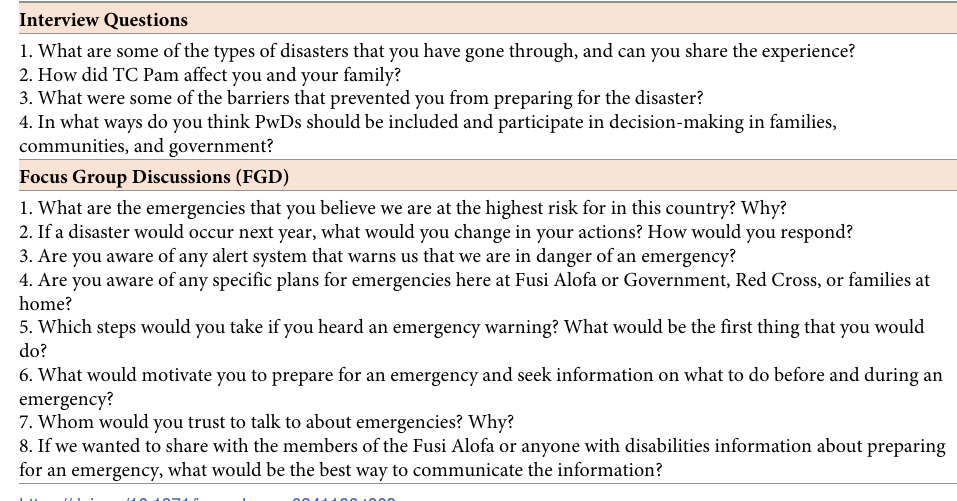
Table 2. Questions for interviews and focus group